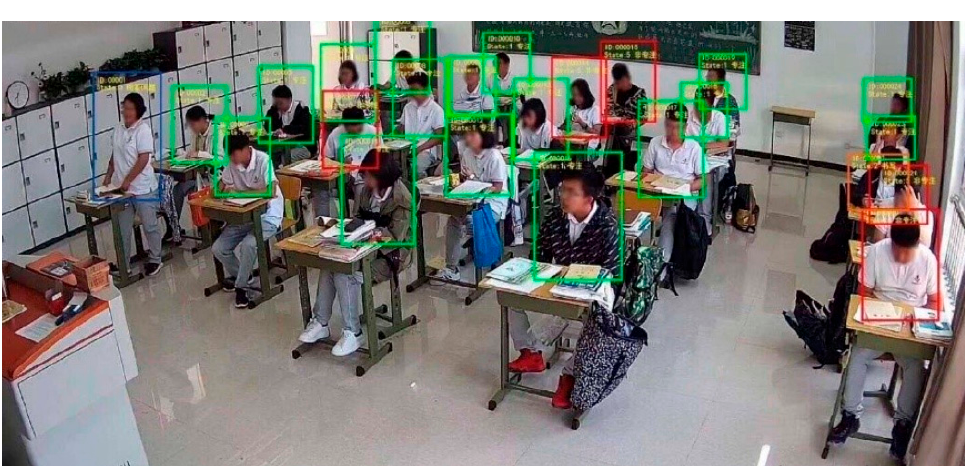
Figure 8. Visualization result illustration.